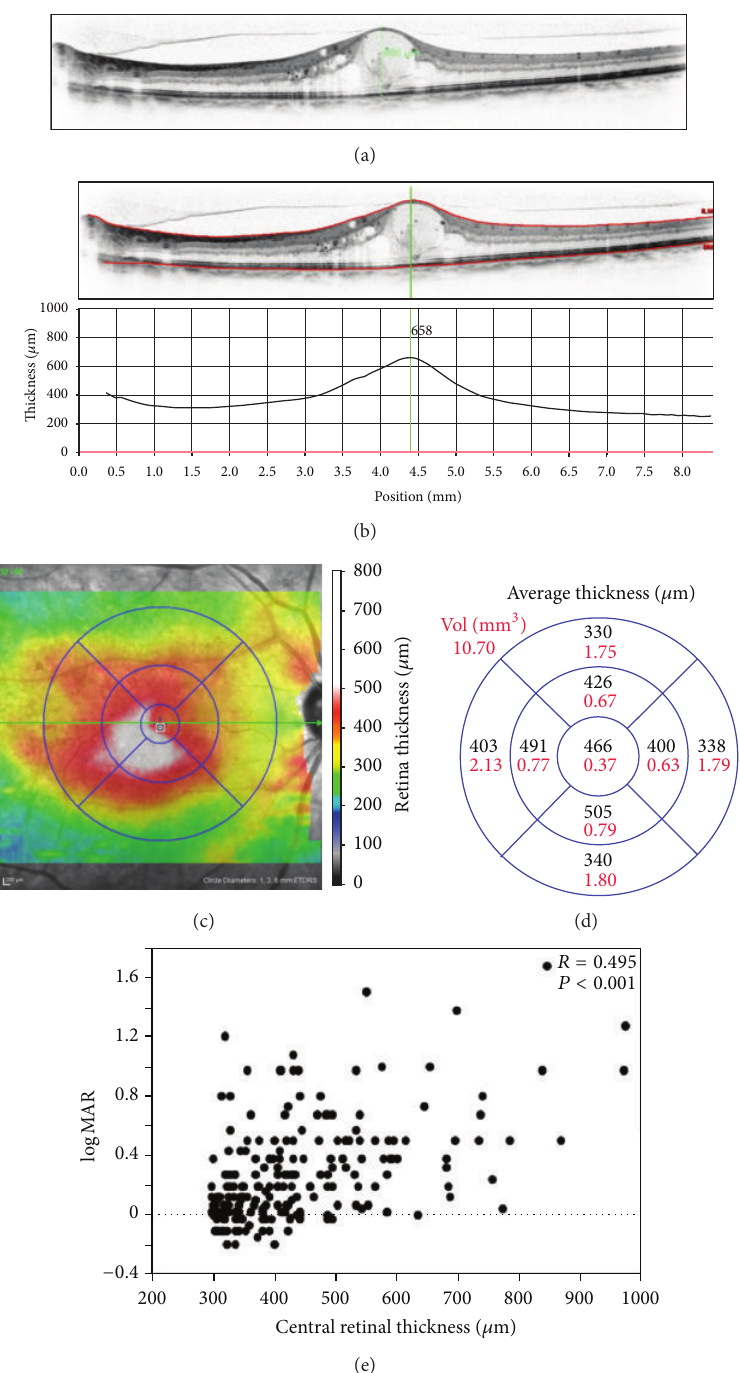
Figure 2: Quantification of the total retinal thickness using OCT. The retinal thickness can be measured semiautomatically (b) or manually using calipers (a). (c) A two-dimensional map of the retinal thickness can be constructed from the automatically measured retinal thickness. (d) The average thickness in each subfield of Early Treatment Diabetic Retinopathy Study grid is shown. (e) The average thickness in the central subfield is correlated modestly with the logarithm of the minimum angle of resolution VA in center-involved